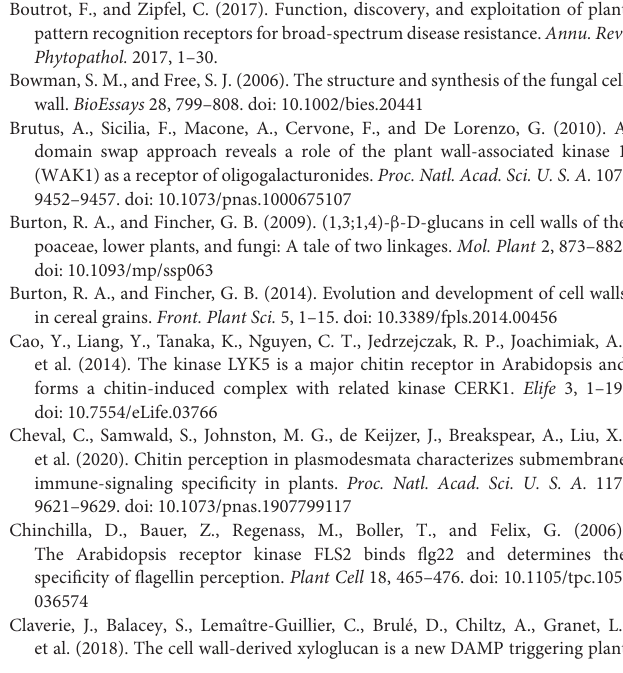
were taken and the enzyme was inactivated by incubation for 15 min in boiling water. For TLC, 5 µ l of the respective hydrolyzate was applied to the plate. As controls, 5 µ l of a mixture of a β -1,3/1,4-MLG tetrasaccharide and trisaccharide (10 mg ml − 1 ) as well as β -1,3/1,4-MLG polysaccharide (10 mg ml − 1 ) were included. The TLC running buffer contained isopropanol:ethylacetate:H 2 O in a ratio of 2:2:1. The carbohydrates were visualized by wetting the plate with 10% sulfuric acid in methanol and incubation at 99 ◦ C for 30–60 min. Supplementary Figure 2 | Verification of masses and HPAEC-PAD profiles of commercially available β -1,3/1,4-MLG MLG oligosaccharides. The purity of the purchased β -1,3/1,4-MLG MLG oligosaccharides was tested with MALDI-TOF (A,C,E,G) and HPAEC-PAD (B,D,F,H) . For MALDI-TOF, 10 µ g ml − 1 of the respective β -1,3/1,4-MLG oligosaccharide was mixed 1:5 with a 2,5-dihydrobenzoic acid MALDI matrix and analyzed. The expected masses of the pure β -1,3/1,4-MLG oligosaccharides as well as the sodium and potassium adducts are indicated. For HPAEC-PAD analysis, 56 or 45 µ M of the MLG tetrasaccharide or MLG trisaccharide, respectively, were analyzed. Supplementary Figure 3 | Thin Layer Chromatography (TLC) of enzymatic degradation of the H. vulgare β -1,3/1,4-MLG polysaccharide. 10 mg ml − 1 β -1,3/1,4-MLG polysaccharide of H. vulgare were dissolved in 100 mM Sodium phosphate buffer (pH = 6.5) and incubated with active lichenase (1 U ml − 1 ) of B. subtilis for 60 min. The enzyme was inactivated by incubating the hydrolyzate for 15 min in boiling water. For TLC, 5 µ l of the hydrolyzate was applied to the plate. The TLC running buffer contained isopropanol:ethylacetate:H 2 O in a ratio of 2:2:1. The carbohydrates were visualized by wetting the plate with 10% sulfuric acid in methanol and incubation at 99 ◦ C for 30–60 min. Supplementary Figure 4 | Lichenase-generated β -1,3/1,4-MLG oligosaccharides induce phosphorylation of MAPK in various Arabidopsis accessions. MAPK activation in 14-day-old seedlings of different A. thaliana ecotypes in response to β -1,3/1,4-MLG oligosaccharides. β -1,3/1,4-MLG oligosaccharides were generated upon incubation of the β -1,3/1,4-MLG polysaccharide (10 mg ml − 1 ) with the B. subtilis lichenase (1 U ml − 1 ) for 60 min ( Supplementary Figure 3 ). For the treatment, a 1:10 dilution of the hydrolysis products was used. Sodium phosphate buffer (1 mM) served as negative control. As loading control, the PVDF membrane was stained with Coomassie Brilliant Blue (CBB). Data show the result from one biological